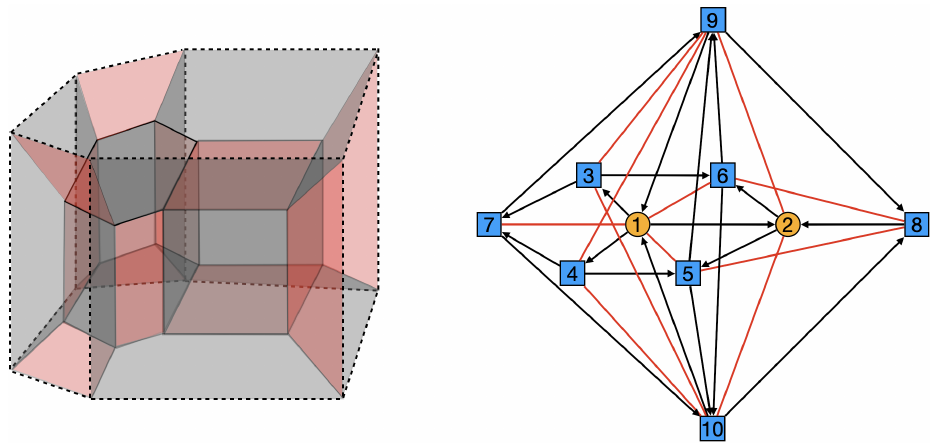
Figure 25 . A hexagonal prism-cube model and its dual